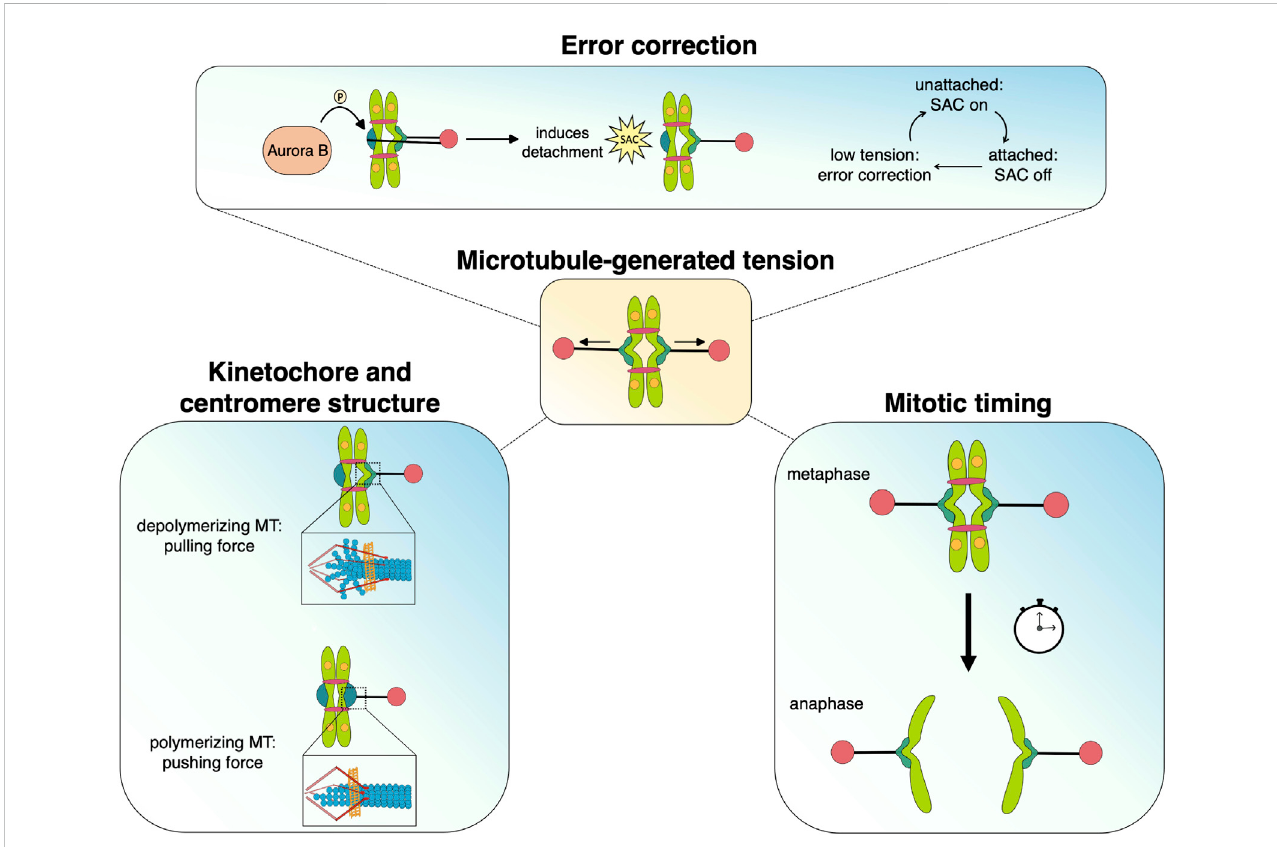
FIGURE 3 Microtubule-generated tension serves as a unifying force that facilitates the processes that promote chromosome segregation during mitosis. Dynamic microtubules generate pushing and pulling forces that move chromosomes as well as alter kinetochore/centromere structure, which may stabilize attachments and silence spindle assembly checkpoint signaling. The tension status at kinetochores also mediates Aurora B-dependent error correction and regulates the timing of anaphase